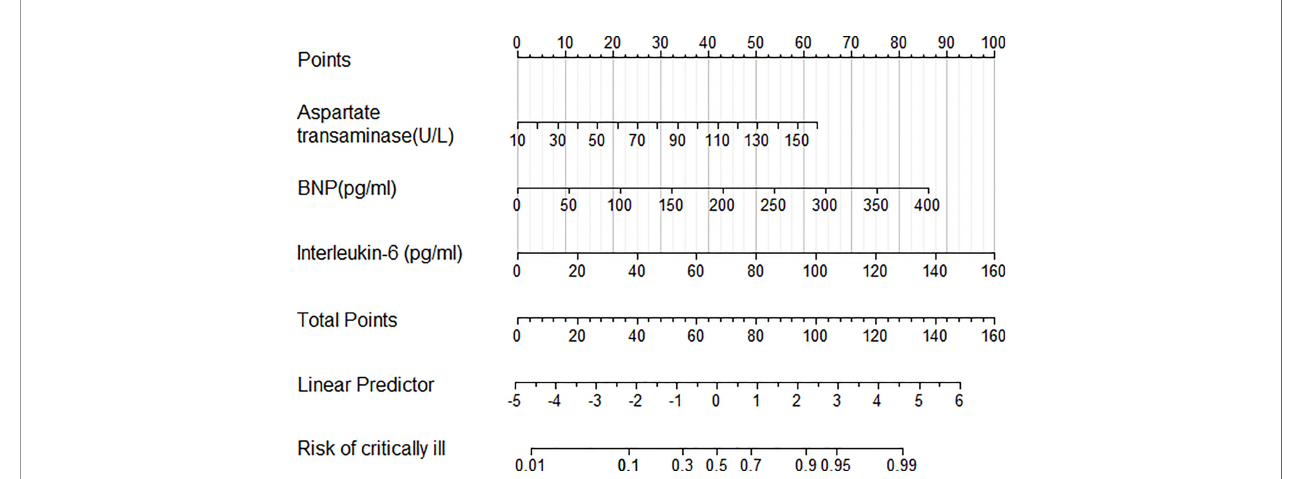
FIGURE 5 | Nomogram predicting the probability of critically ill COVID-19 related pneumonia patients. To obtain the nomogram-predicted probability, patient values have been plotted on each axis. A vertical line to the point axis depicts attributes for each variable value. Summing the points for all variables and obtaining the sum for the point line leads to assessment of the individual probability of critically ill COVID-19 related pneumonia patients.